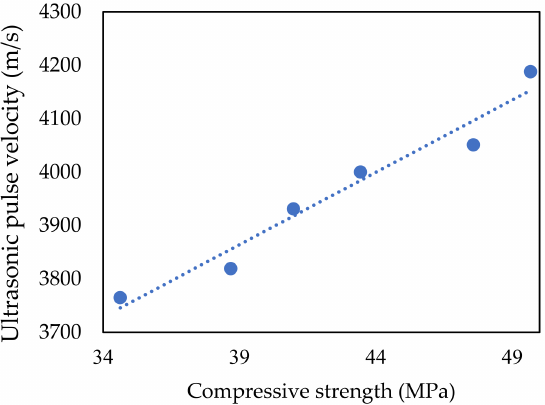
Figure 13. The relationship between ultrasonic pulse velocity and compressive strength.